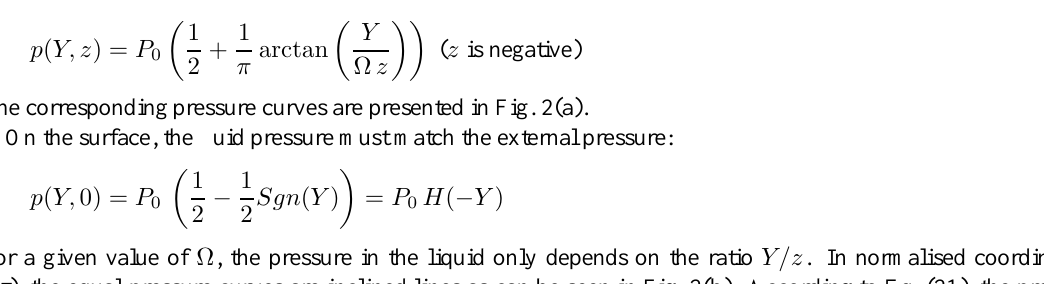
Fig. 2. Acoustic pressure in a infinite half space of liquid loaded by a subsonic pressure step (a), and equal-pressure curves